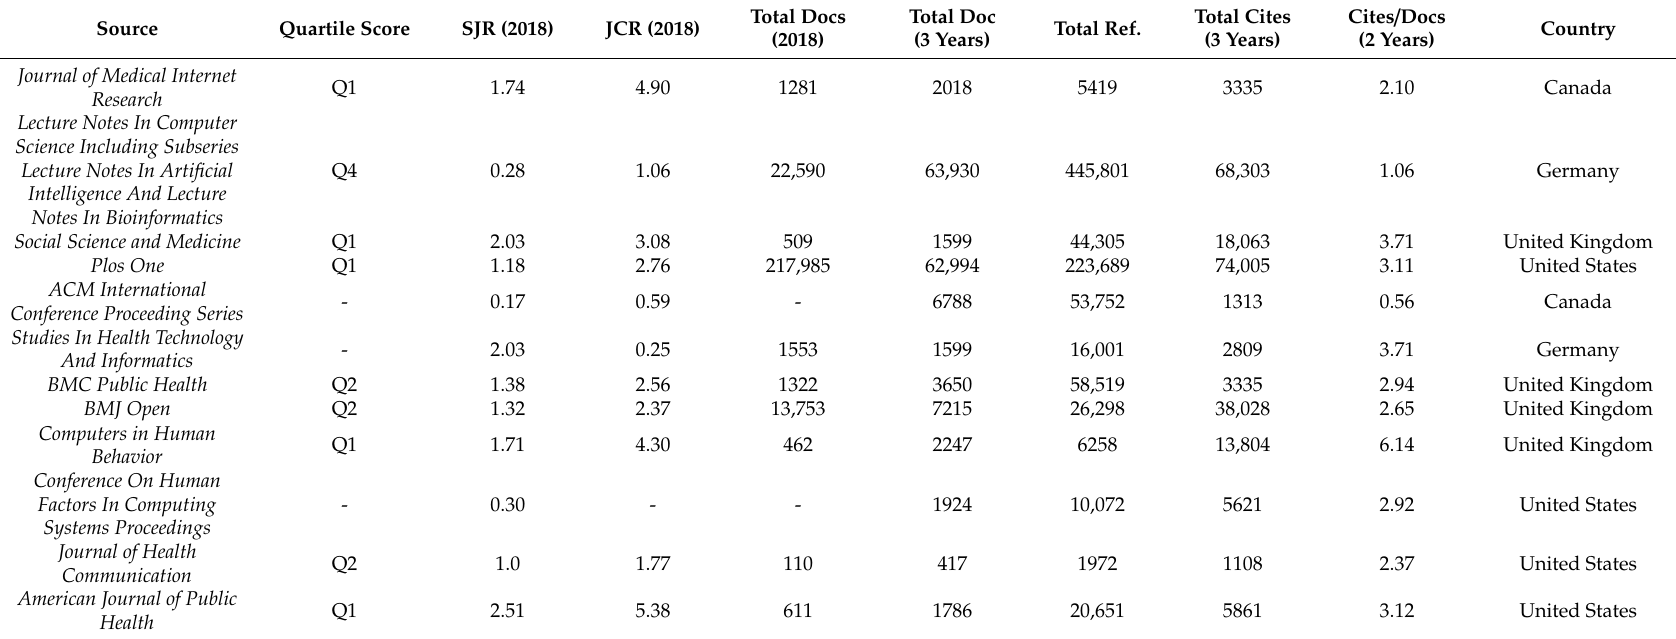
Table 5. Quartile, Scimago Journal Rank (SJR), and Journal Citation Report (JCR) of major worldwide